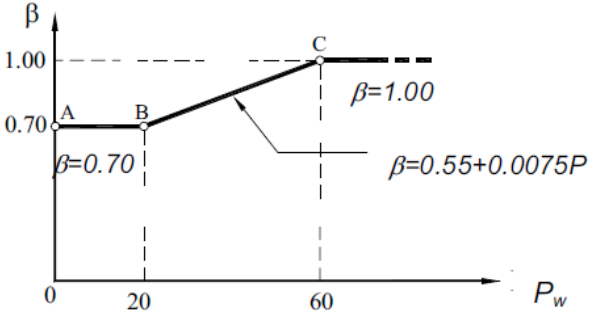
Table 5. w i values for P i scores (Gulay et al., 2008).